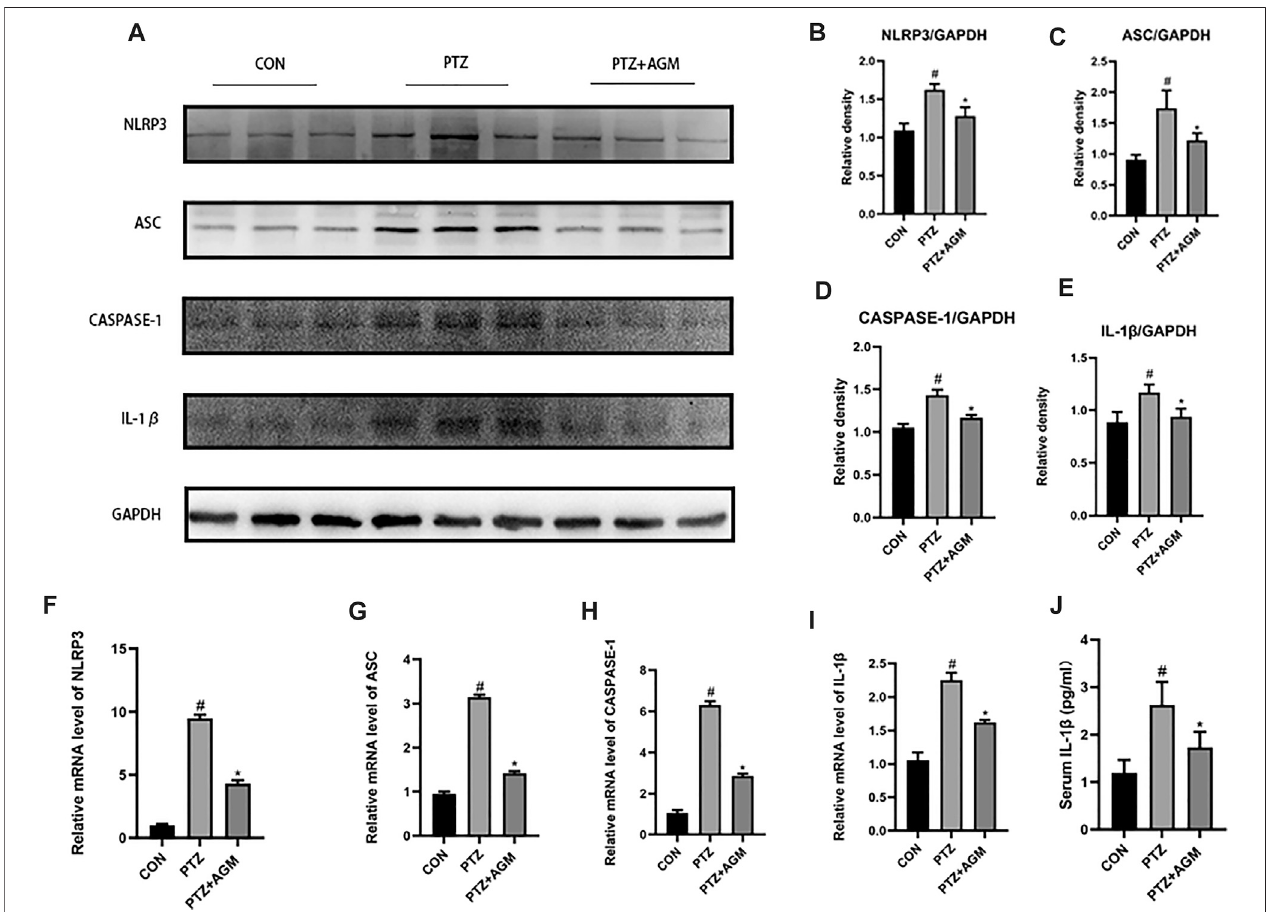
FIGURE 4 | Effects of AGM on hippocampal in fl ammation-related proteins and mRNA in PTZ kindled mice. (A – E) Proteins expression level of in fl ammasome (NLRP3.ASC,CASPASE-1,IL-1 β )indifferentgroups(n (cid:1) 4mice per group,Student ’ stest). (F – I) mRNAexpression level ofin fl ammasome(NLRP3,ASC,CASPASE-1,IL- 1 β )indifferentgroups(n (cid:1) 4micepergroup,Student ’ stest). (J) ThepresenceofIL-1 β wasmeasuredbyELISA(n (cid:1) 4micepergroup,Student ’ stest).Alldataareshown as mean ± standard deviation.# p ＜ 0.05 vs the control and PTZ group, * p ＜ 0.05 vs the PTZ group and PTZ + AGM group.